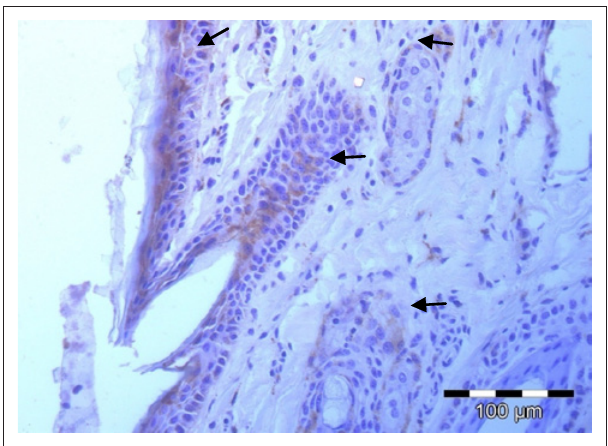
FIGURE 5: Positive NovaRED-stained fibroblasts in the dermis (arrows) of a persistently infected calf (Magnification: 40x).